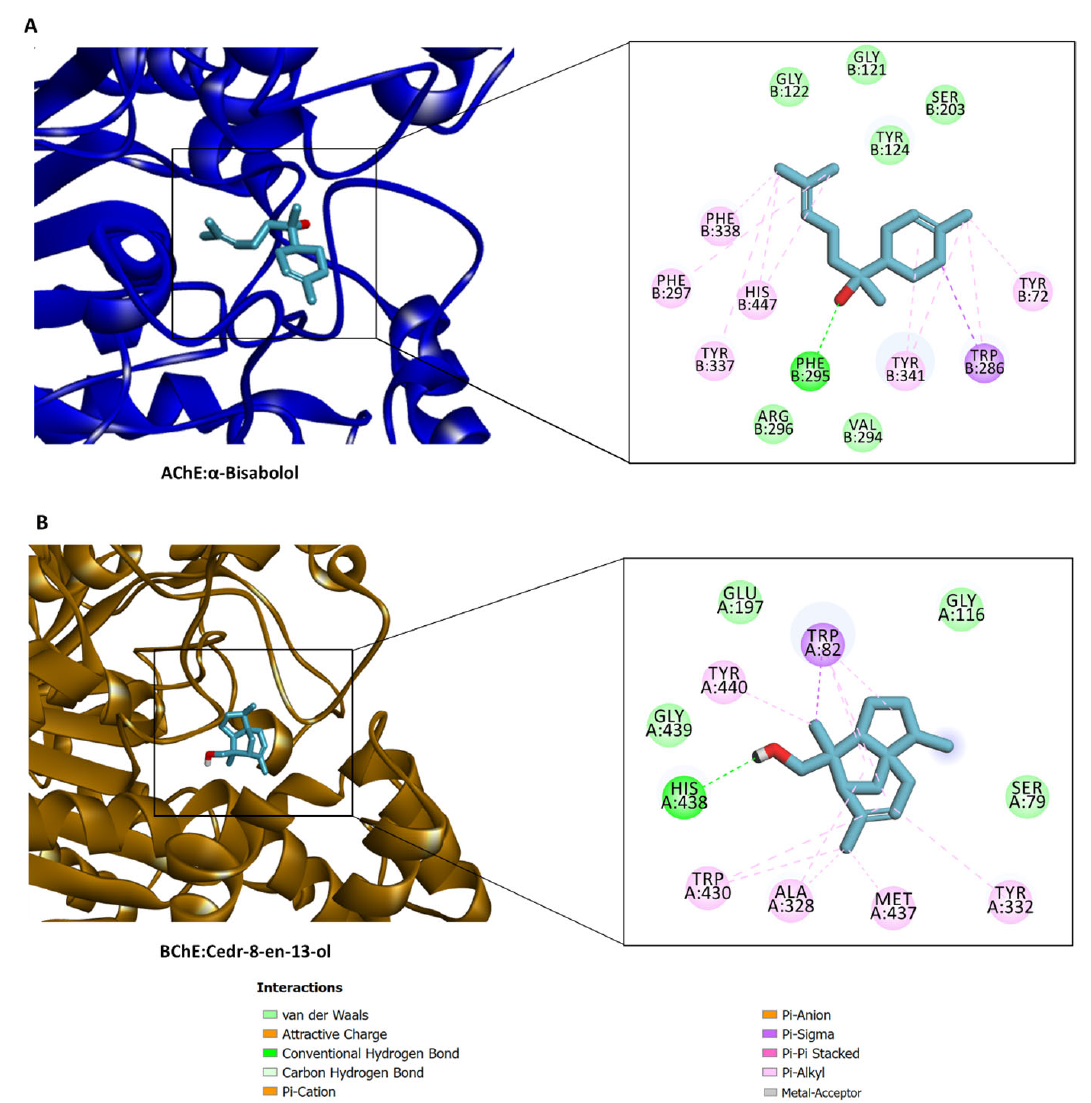
Figure 5. Protein–ligand interaction: ( A ) AChE and α ‑bisabolol and ( B ) BChE and cedr‑8‑en‑13‑ol. These phytochemical compounds were extracted from C. obtusa, C. nigritanus and L. coronopifolia.